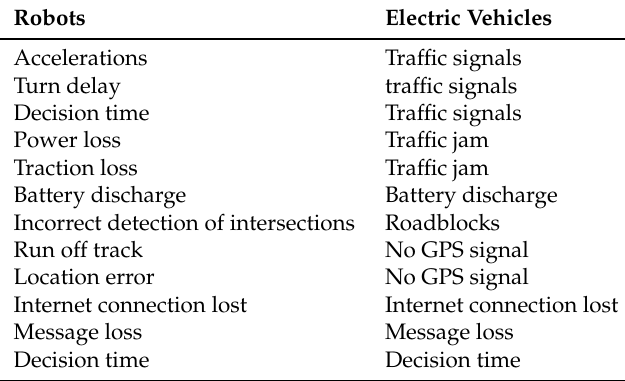
Table 1. A tentative mapping between the robot and the real electrical vehicles (EVs) domain for the most common incidents found in the laboratory